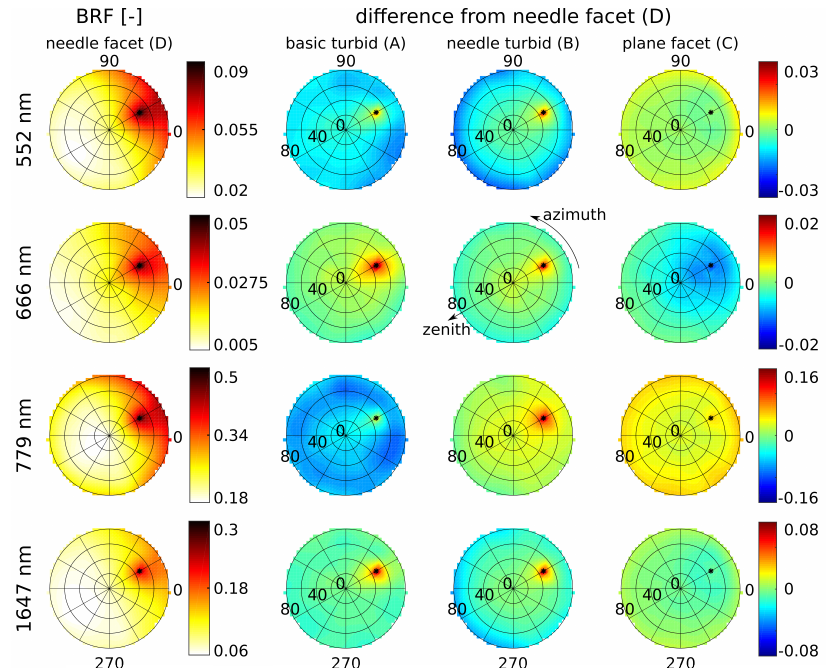
Figure 9. Multi-angular distribution of simulated forest canopy reflectance in four spectral bands (green—552 nm, red—666 nm, NIR—779 nm, and SWIR—1647 nm) for the most complex canopy scenario D , needle facet , (left plots), followed by the reflectance differences between scenario D and other three scenarios ( A , B , and C ).